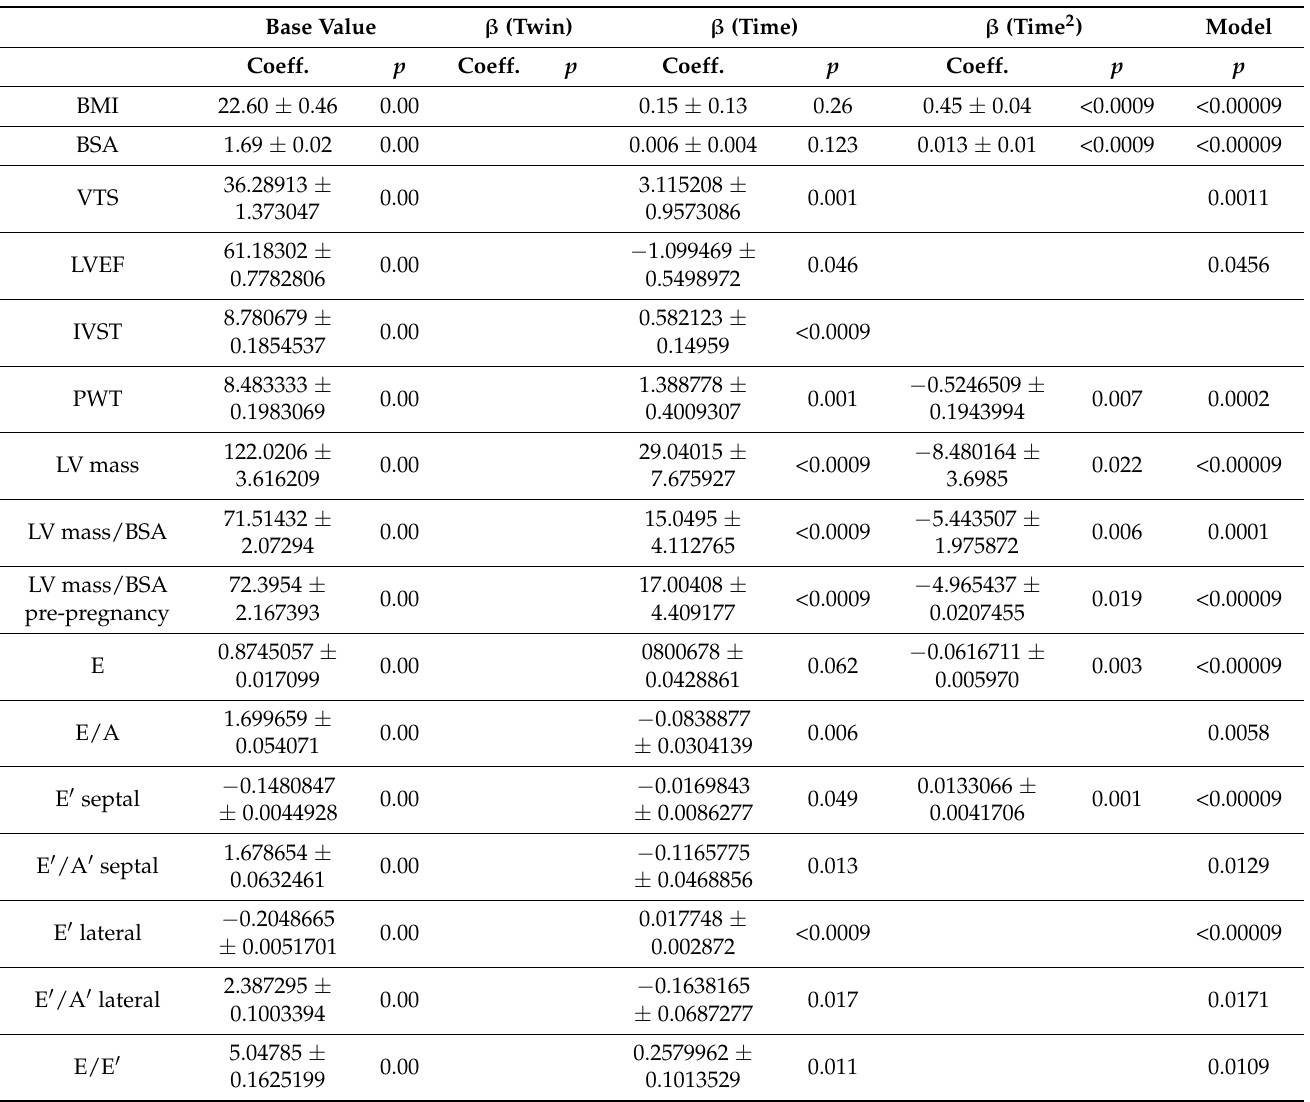
Table 3. Longitudinal regression analysis model based on: Y_ij = β _0 + β _01*Twin + β _i1 t_ij + β